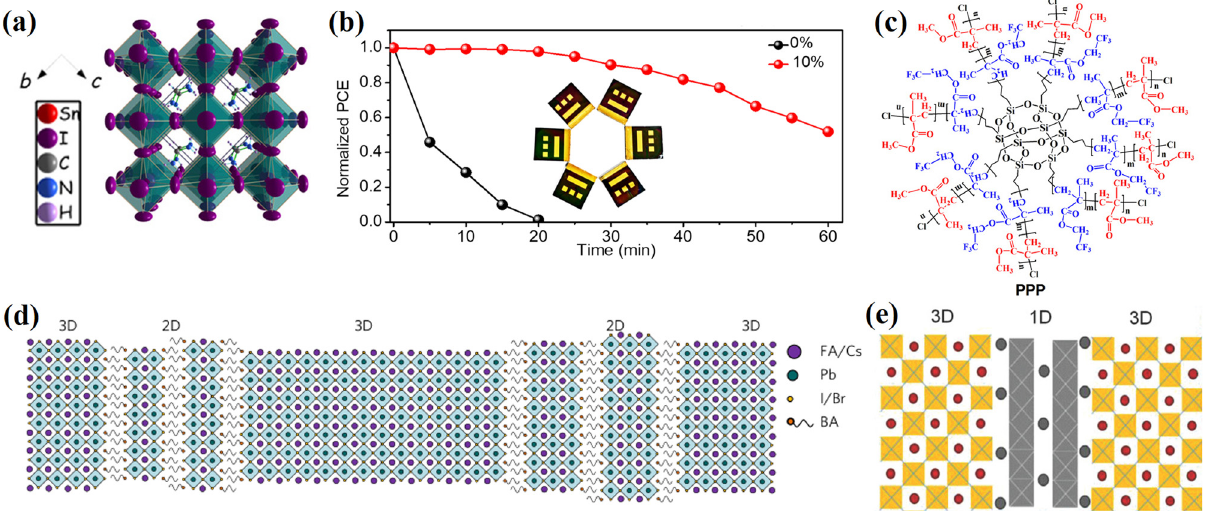
Figure 2: ( a ) Crystal structure of { en } FASnI 3 . ( b ) Under constant conditions, an aging test of { en } FASnI 3 - based unencapsulated solar cells with and without 10% en. Reproduced with permission from ref. [ 43 ] . Copyright 2017, American Association for the Advancement of Science. ( c ) Structural formula of PPP polymer for fabricating PPP - based 3D structure perovskite, reproduced with permission from ref. [ 50 ]